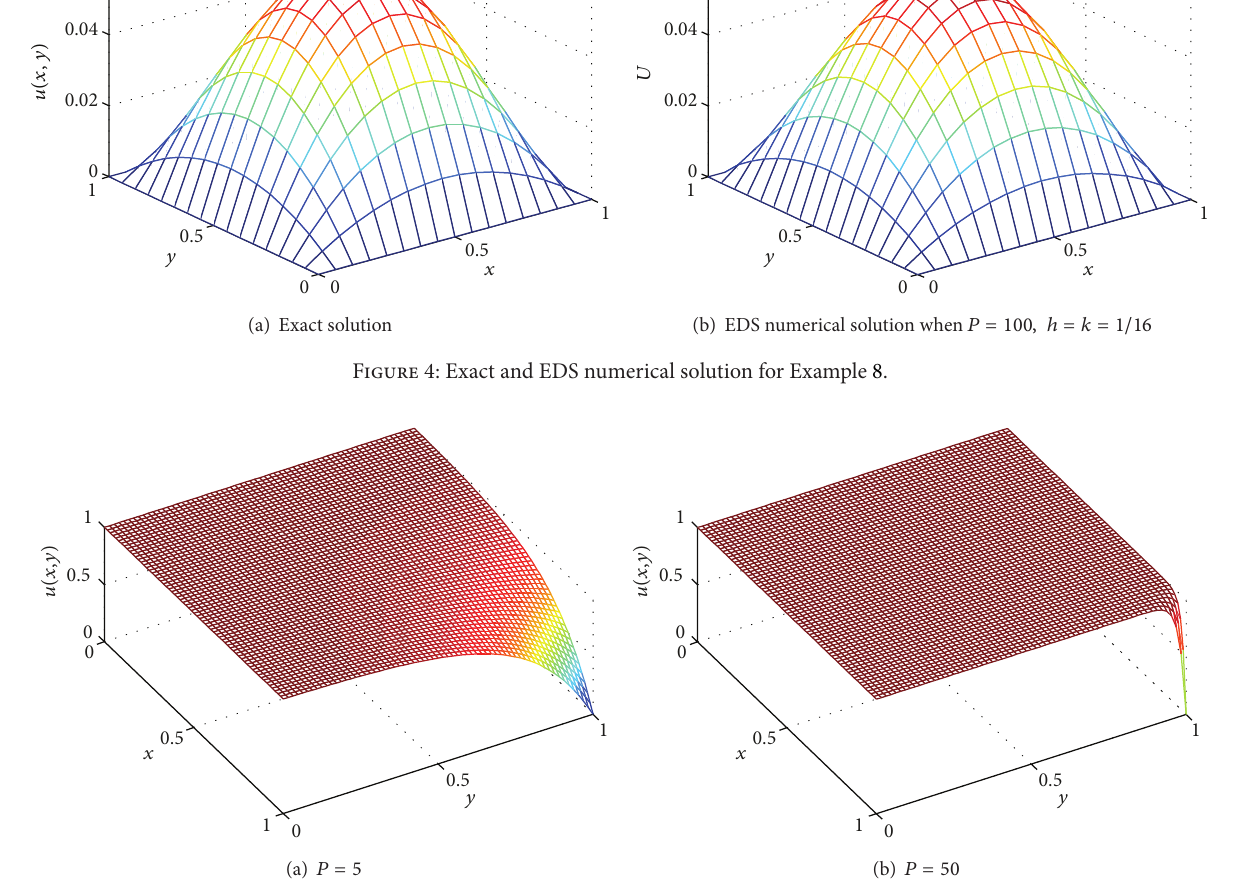
Figure 5: Exact solution of Example 9 for different values of 𝑃